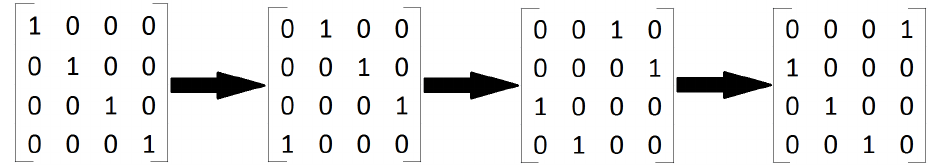
Figure 2. Shifts of the submatrixes matrix P by 0, 1, 2 and 3